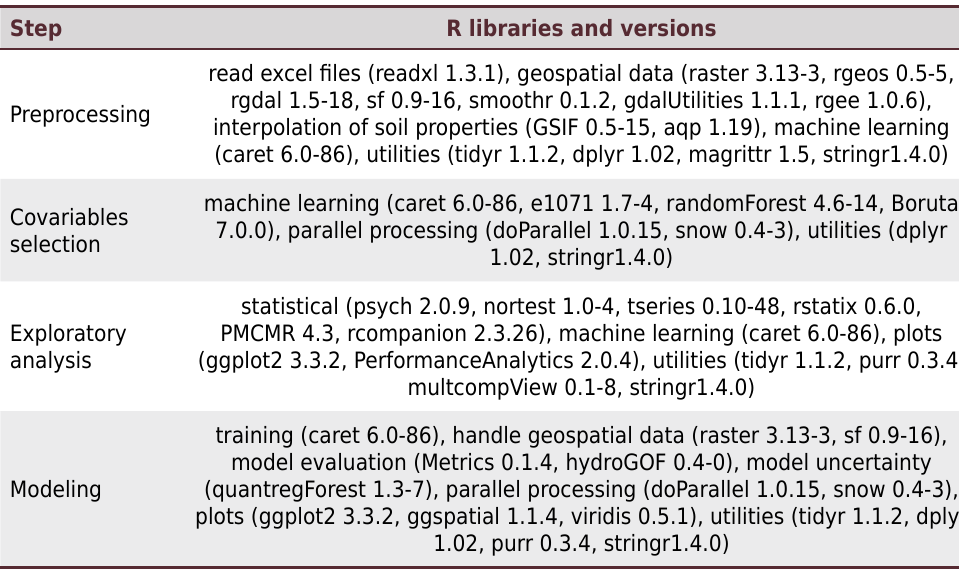
Table 3. Lists of key R-libraries used by the pipeline per step Step R libraries and versions